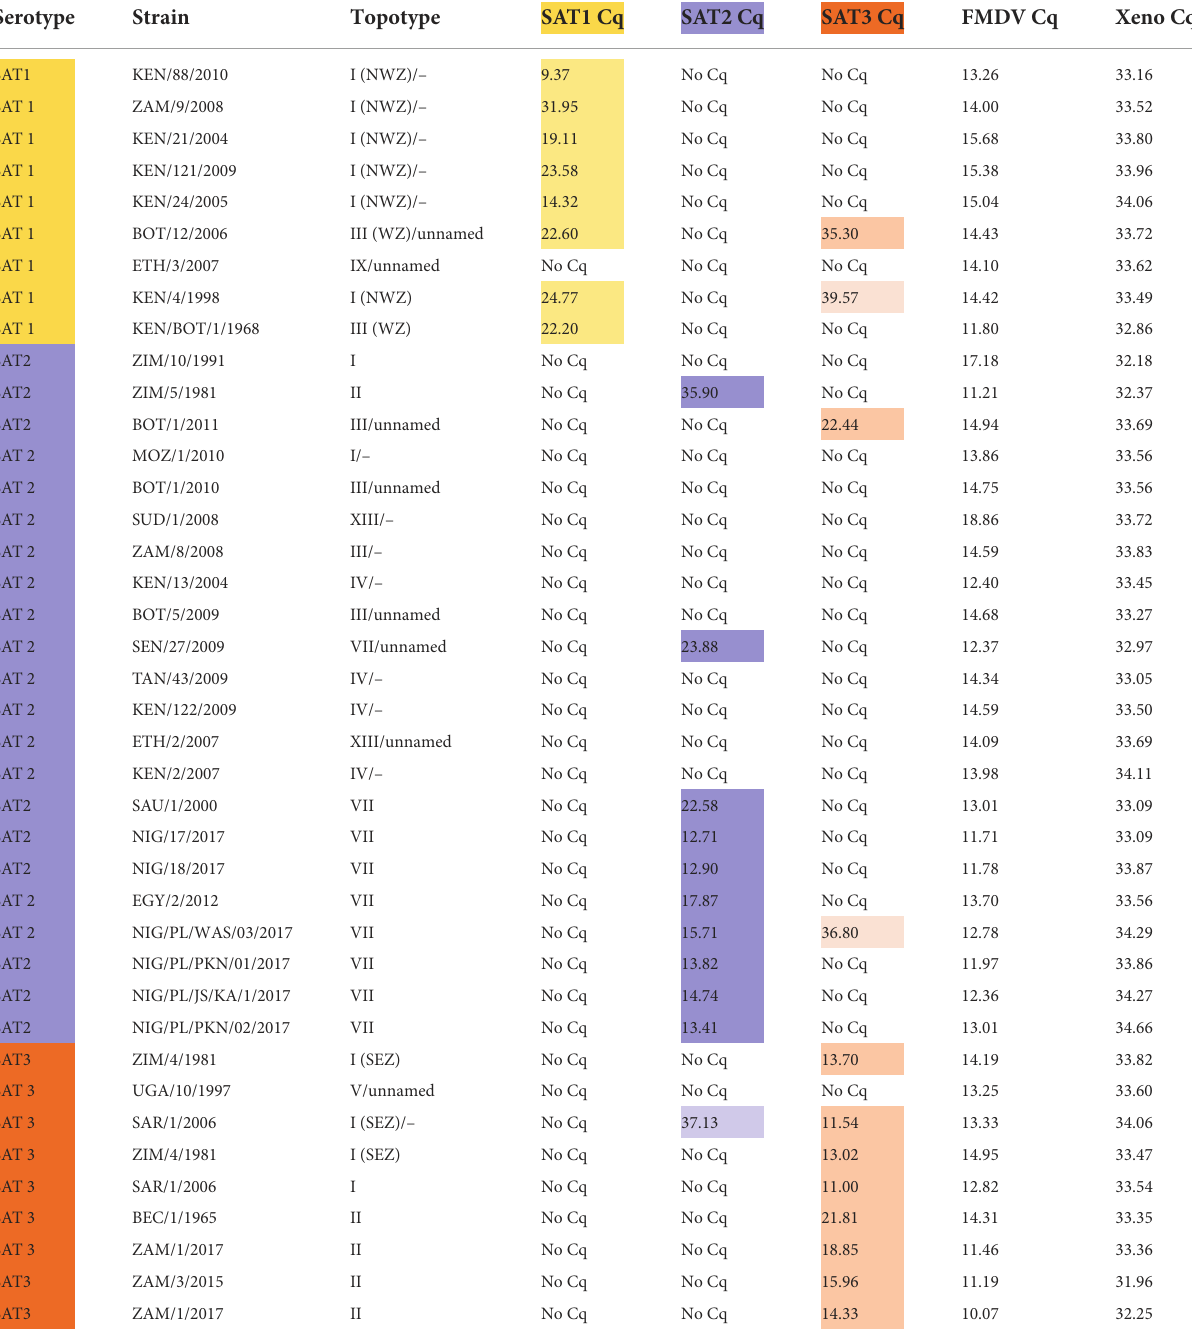
TABLE 4 Detection of FMDV SAT1, SAT2 and SAT3 cell culture isolates with the SAT1, SAT3 and SAT2 topotype VII rRT-PCR assays.